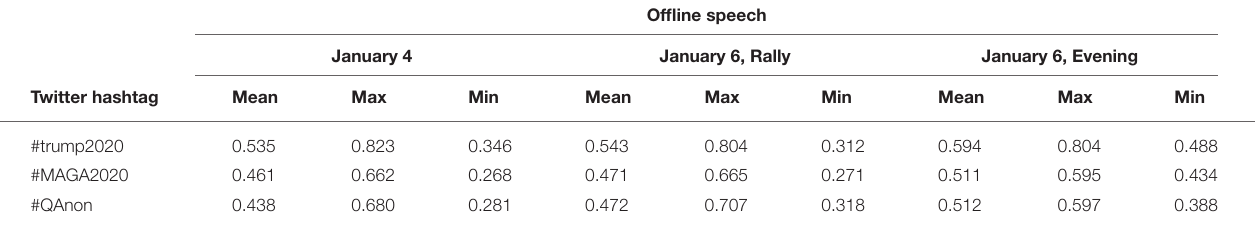
TABLE 1 | Descriptive statistics: similarity scores comparing offline speech and